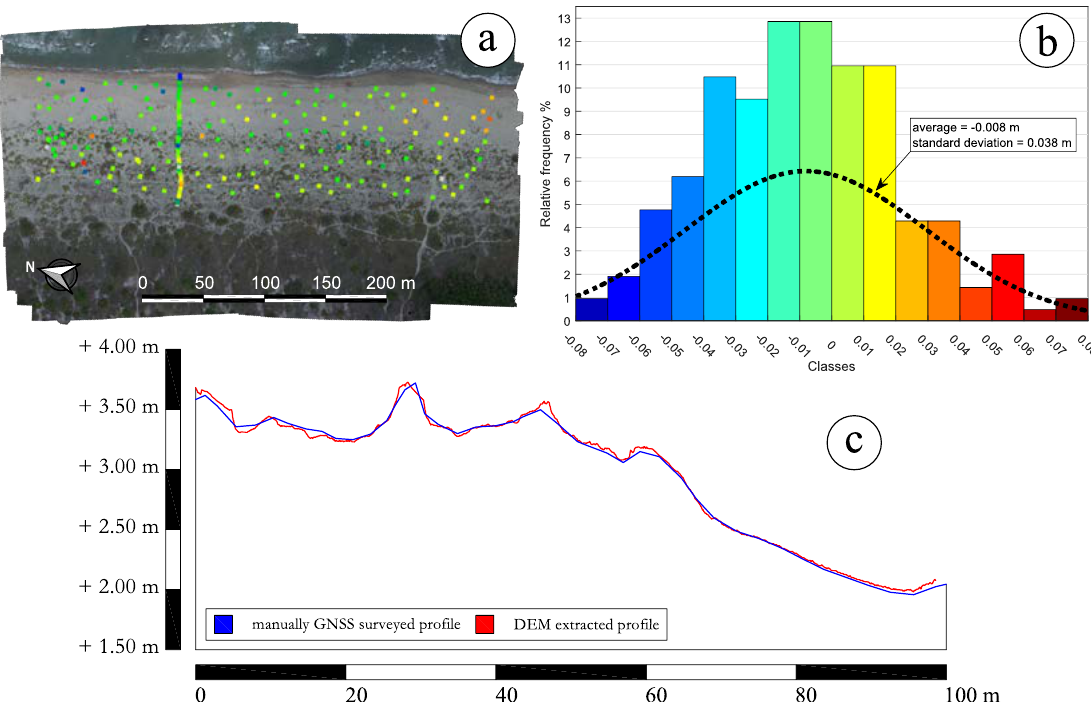
Figure 12. ( a ) Set of ground points used for the comparison between the DEM of November 2016 and the GNSS-surveyed elevations; ( b ) Validation results by histograms: the standard deviation value is comparable with the assumed accuracies of the SfM approach with a 2 cm GSD; ( c ) Comparison between GNSS and DEM on a profile. Discrepancies are still comparable with the SfM